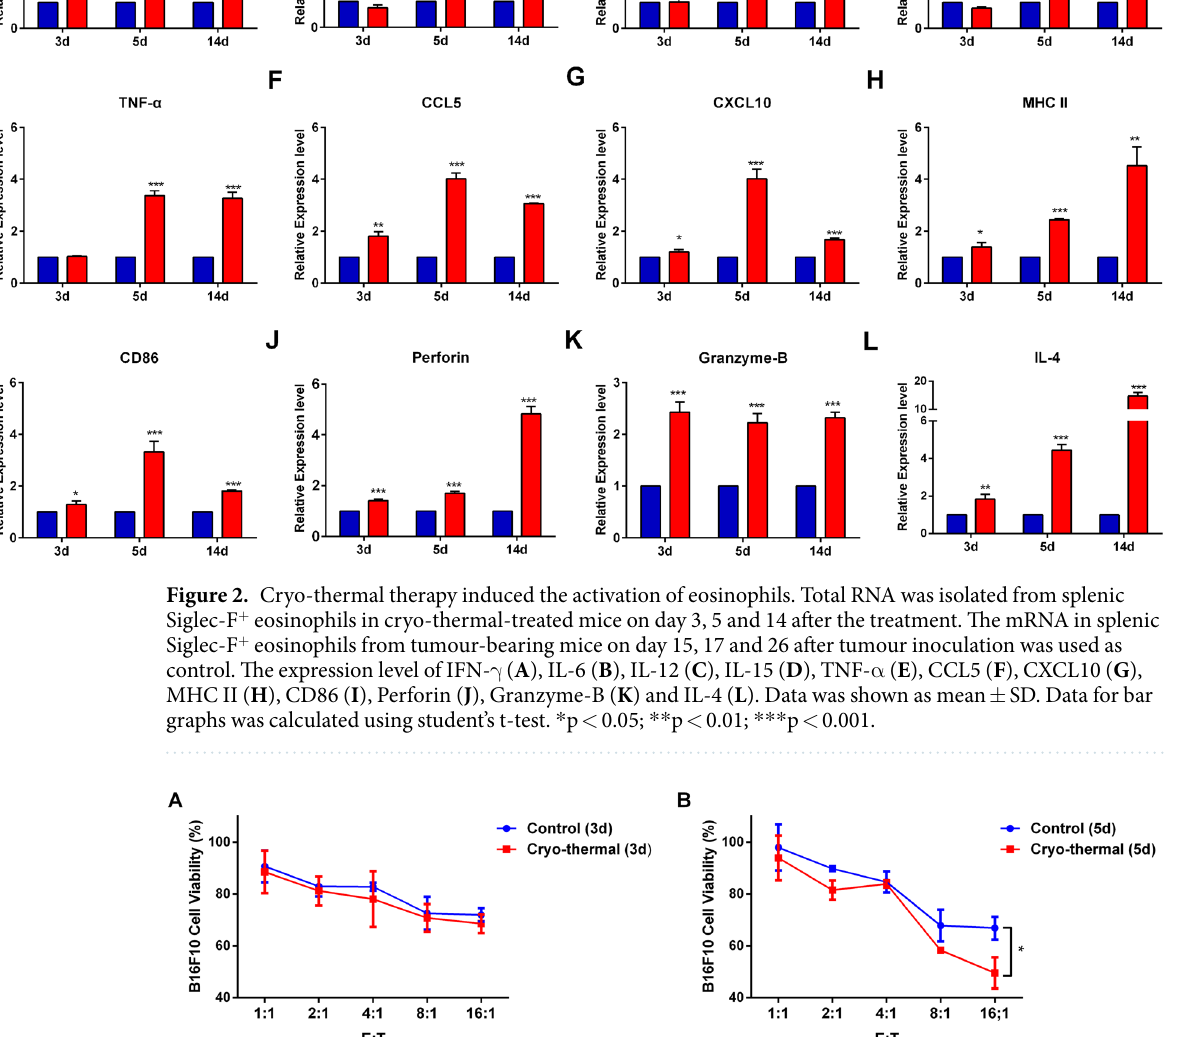
immunoregulatory molecules, Arg-1 and CD206 after cryo-thermal therapy + Siglec-F mAb treatment was found. Meanwhile, the expression level of IL-10, iNOS and CCL22 in cryo-thermal therapy + Siglec-F mAb group was significantly decreased as compared to that in cryo-thermal therapy + isotype group, and the level of CCL17 and CCL2 were unchanged in two groups (Fig. 4I). The result showed that cryo-thermal-activated eosinophils could effectively induce M1 macrophage polarization, moreover, the effect of cryo-thermal-activated eosino- phils on M1 macrophage polarization was much stronger than the effect of eosinophils on DCs activation and maturation.